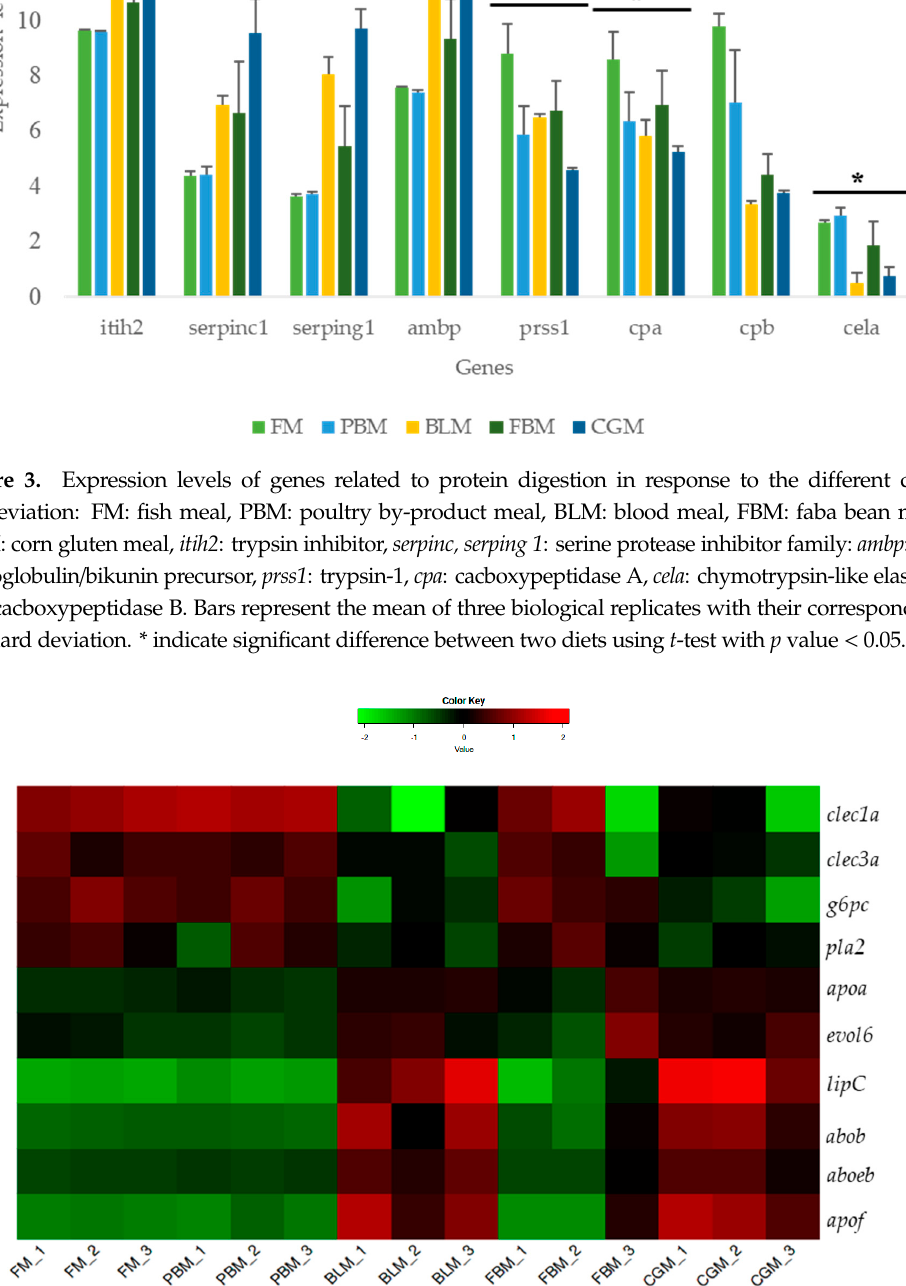
Figure 4. Expression levels of genes related to lipid and carbohydrates metabolism in fish fed different